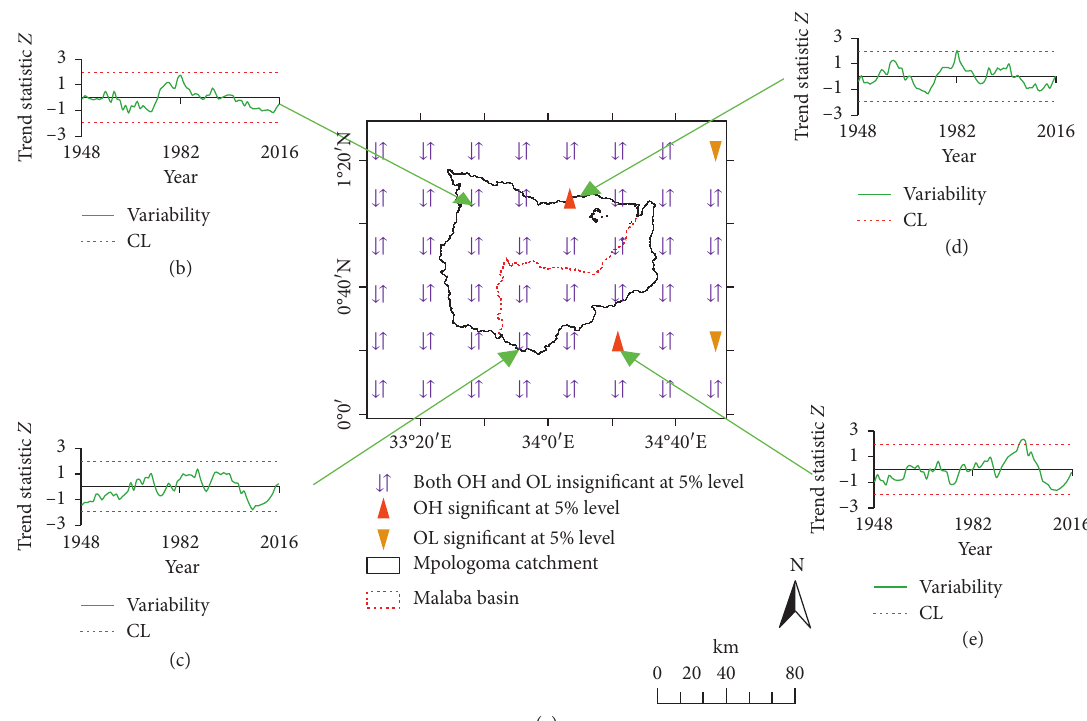
Figure 7: Spatial differences in the significance of annual evapotranspiration variability (a) and temporal variability in annual evapo- transpiration (b–e) at different locations of the study